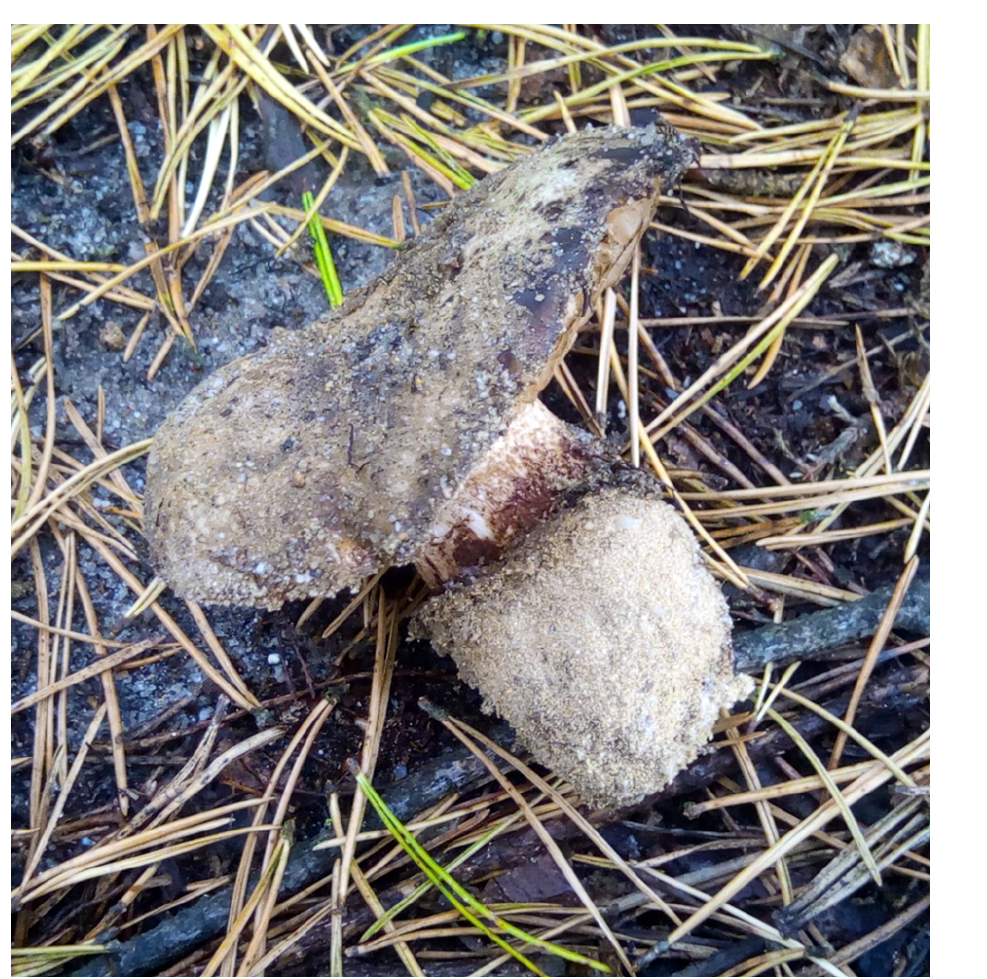
Figure 3 Tricholoma colossus , a species on the red list in category E